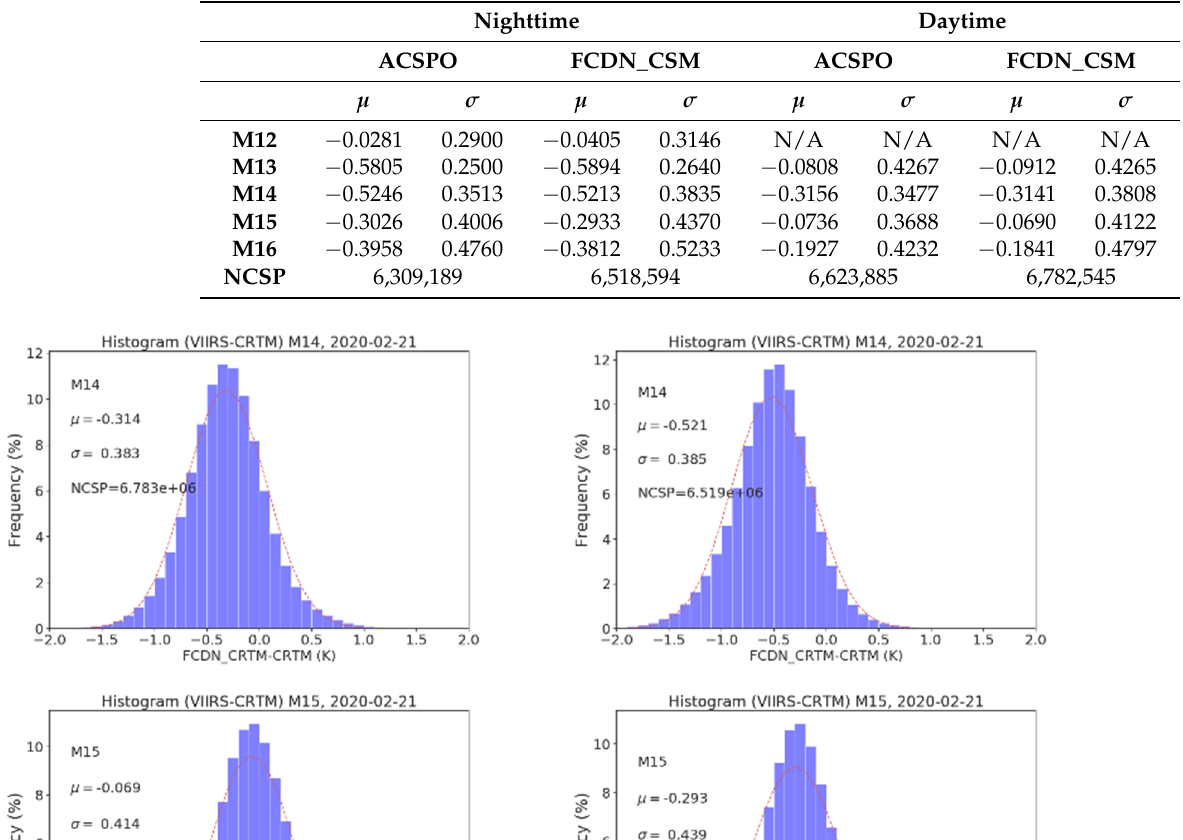
Table 5. Global O-M statistics for 21 February 2020 day and night in the bands M12–M16 with clear- sky identification using ACSPO CSM and FCDN_CSM. ( µ : O-M mean; σ : O-M standard deviation;